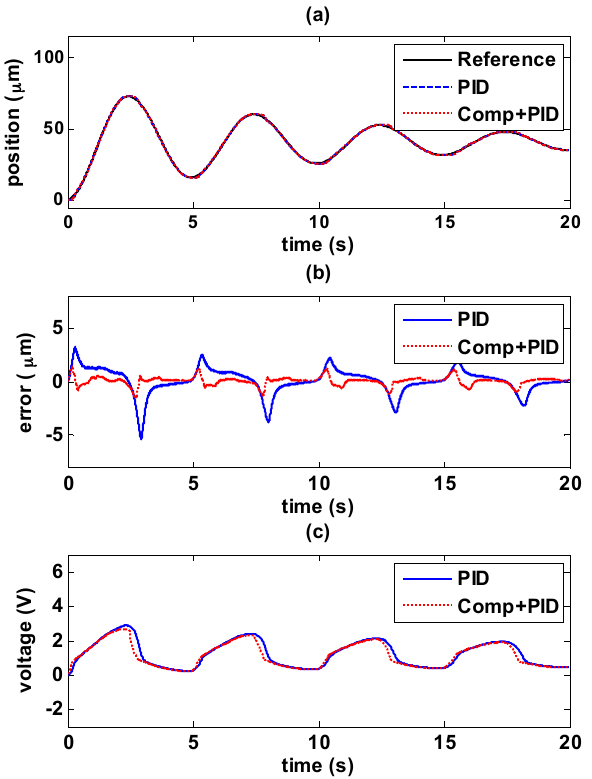
Figure 17. Tracking control comparisons of decaying sinusoidal trajectories with 0.2 Hz frequency between using PID path controller solely and PID path controller with the hysteresis compensator: ( a ) path tracking responses; ( b ) control errors; ( c ) control signals.